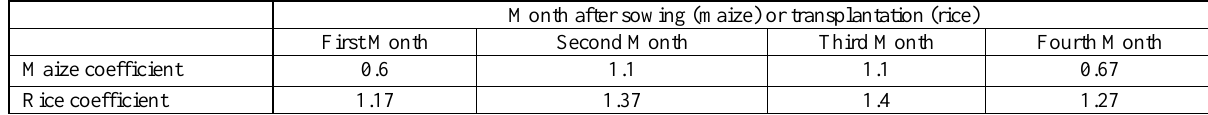
Table 1. Crop Coefficients Representing Water Needs for Maize and Rice Month after sowing (maize) or transplantation (rice) First Month Second Month Third Month Fourth Month